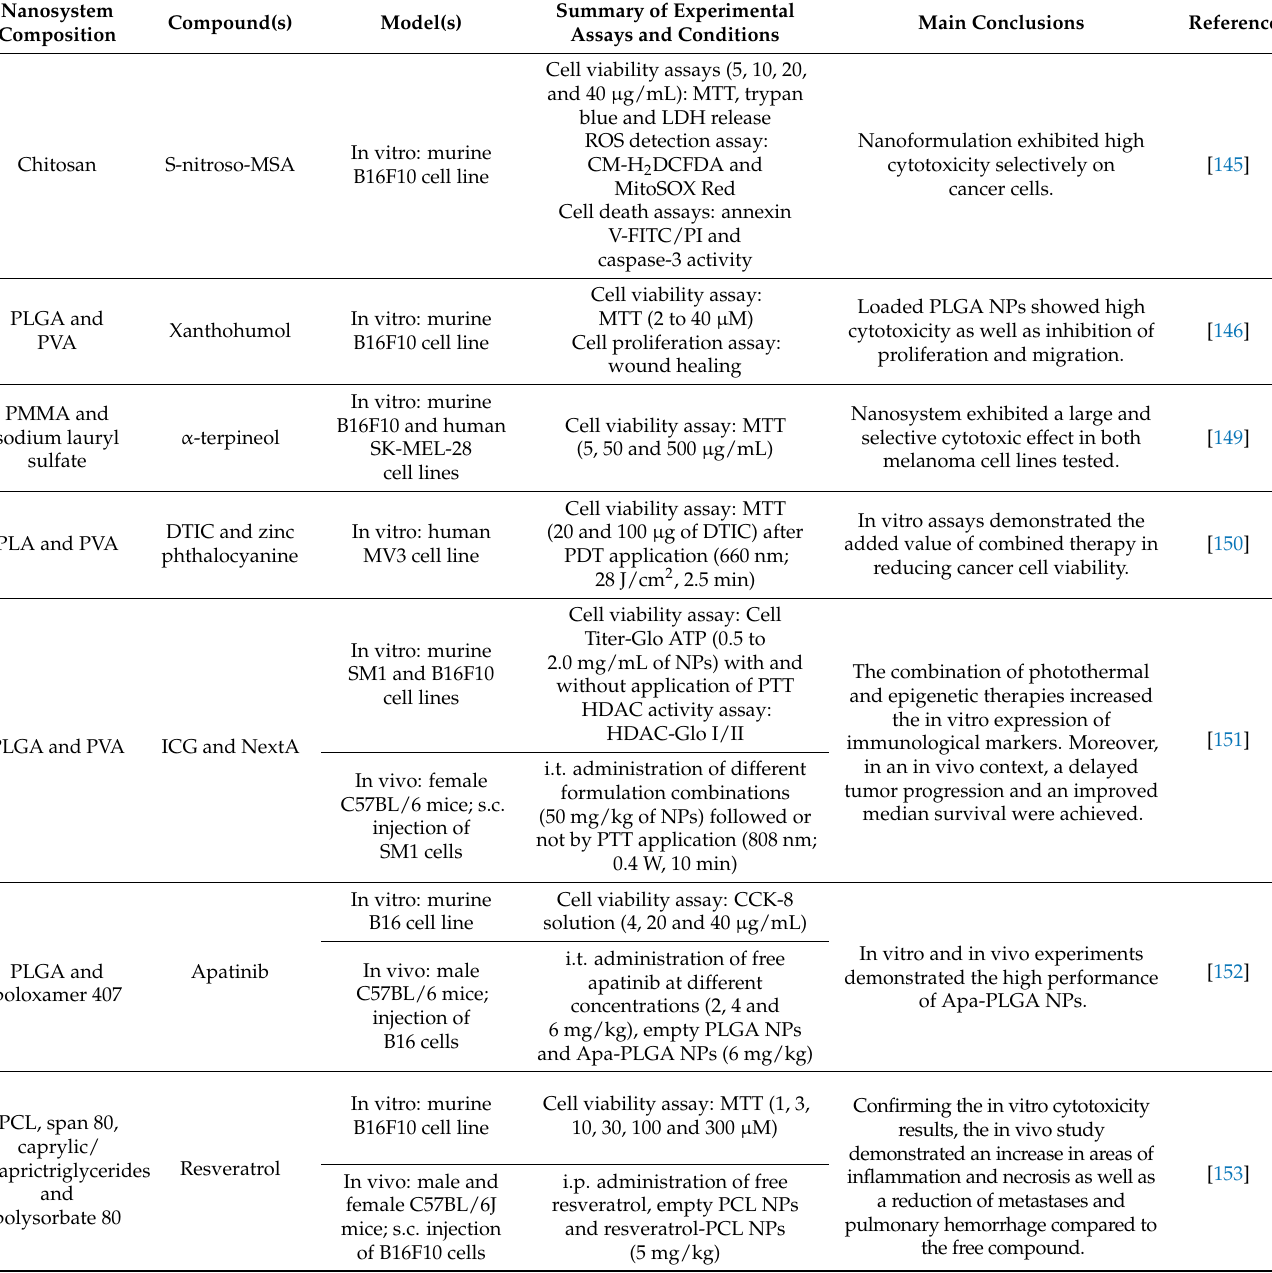
Table 4. In vitro and in vivo assessment of the therapeutic potential of different polymeric-based nanoparticles in melanoma